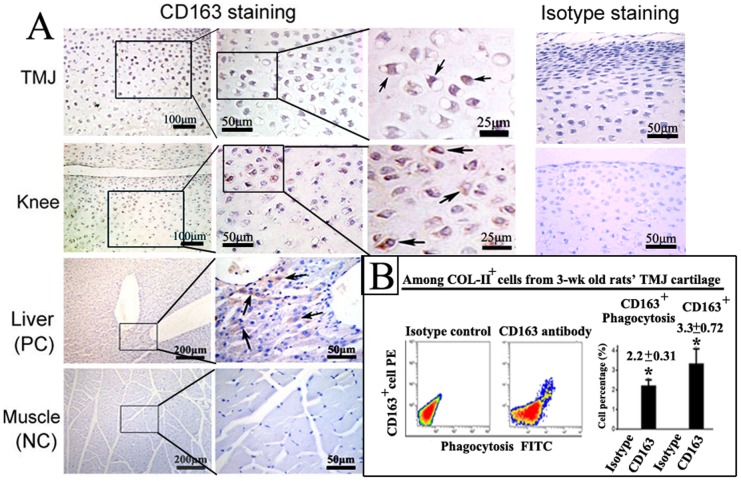
CD163+ chondrocytes in normal joint cartilage of 3-week old rats.A: Immunohistochemical staining of CD163 in cartilage from the TMJ and knee. The CD163+ cells located below the superior zone of the TMJ and knee cartilage, show intense membrane and cytoplasmic staining (arrows). Rat liver and muscle were selected as positive and negative controls, respectively, for the detection of CD163. Membrane staining of CD163+ cells was observed in liver (indicated by arrows), but no CD163+ cells were detected in muscle. As additional controls, TMJ and knee cartilage was also stained with an isotype control antibody. B: Flow cytometric analysis and graphical representation of the percentage of total CD163+ cells and CD163+ cells with phagocytic activity within the Col-II+ cells isolated from TMJ cartilage (n = 3; *P<0.05).